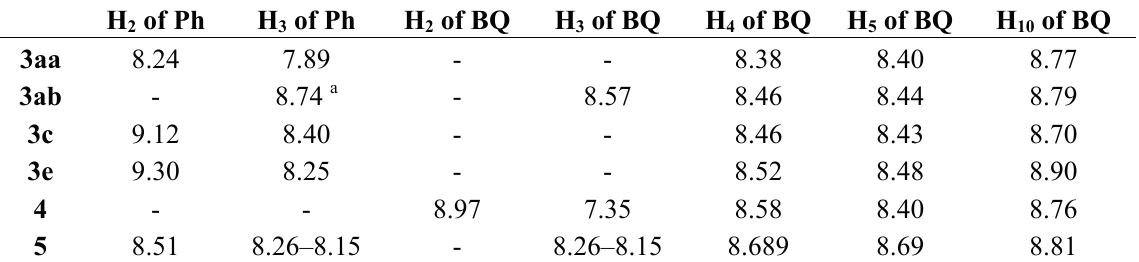
Table 1. Selected proton resonances for compounds 3 , 4 and 5 .